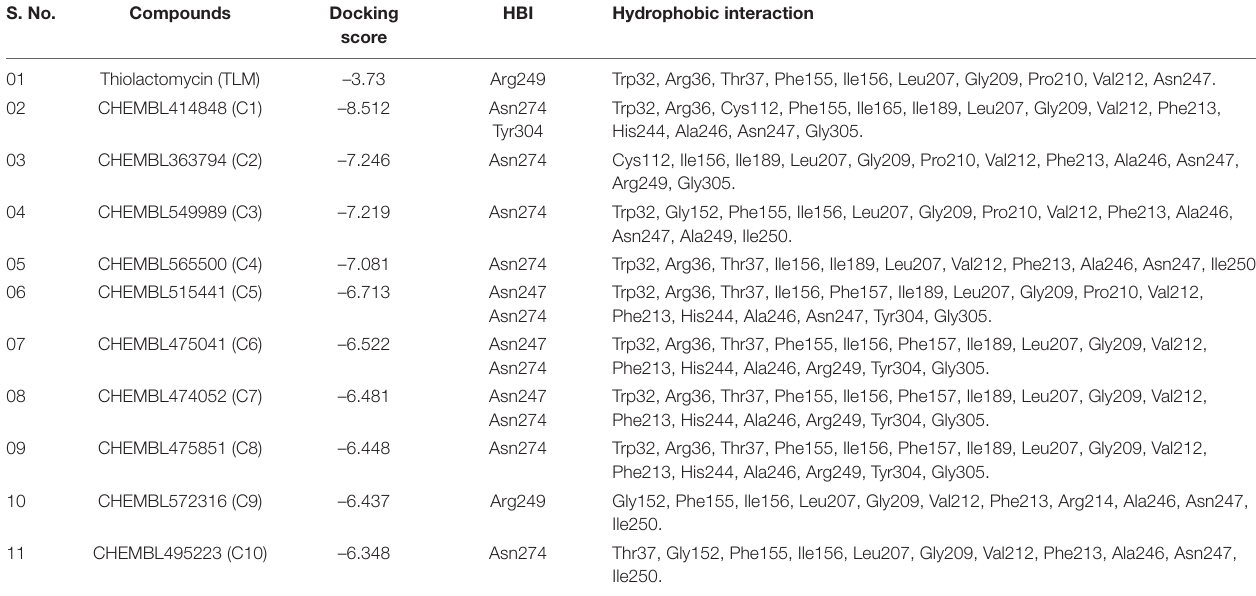
TABLE 1 | Molecular docking of docking and post-docking analysis of CHEMBL (bioactive) antituberculosis compounds against mtFabH. S. No.